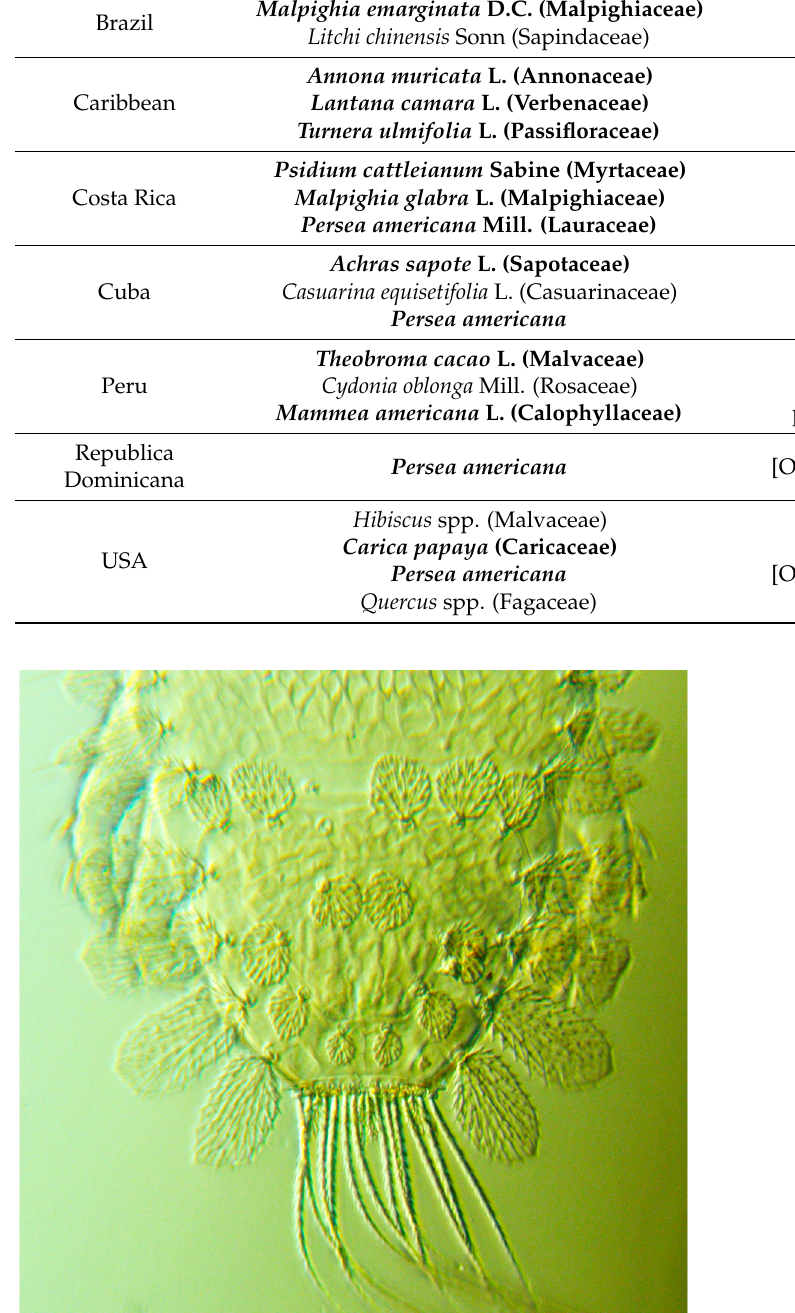
Figure 4. Dorsal view of opisthosoma of adult female Tuckerella pavoniformis .